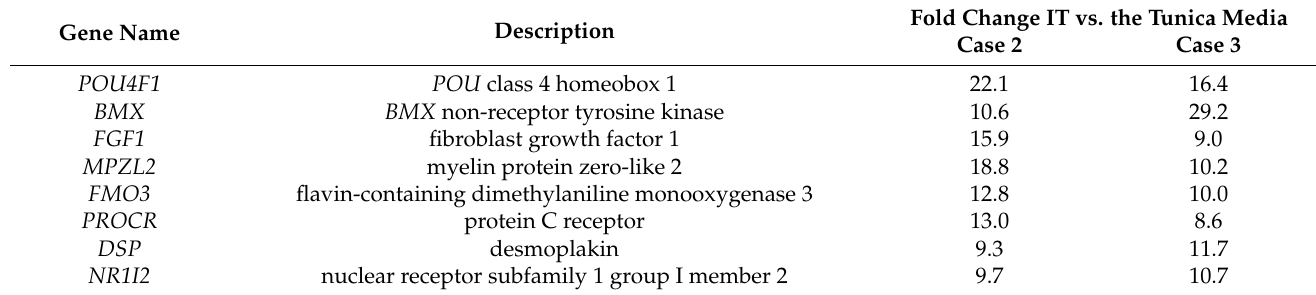
Table 7. Eight genes that overlapped and were enriched (>8-fold) in the intimal thickening (IT) compared to the tunica media of the closing DA tissues (Cases 2 and 3).